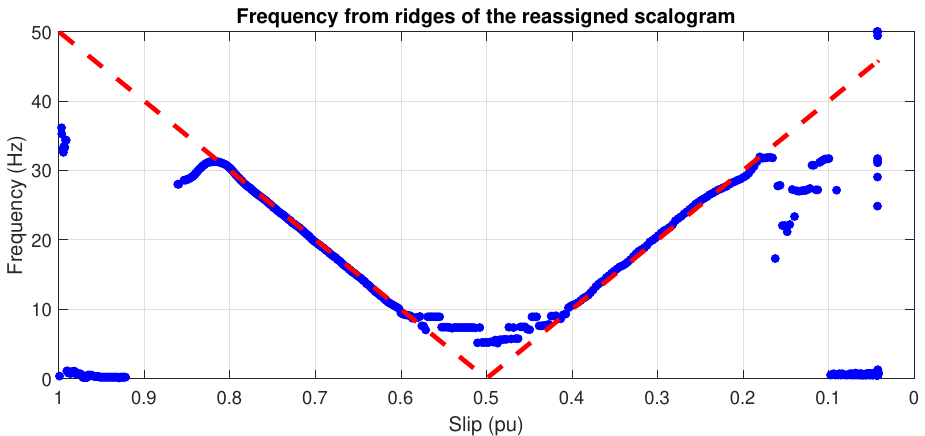
Figure 7. Instantaneous frequency of the LSHst in the slip–frequency plane, obtained from the scalogram ridges. Dashed, red line: theoretical evolution of the fault harmonic. Blue dots: evolution of the LSHst of the simulated machine.